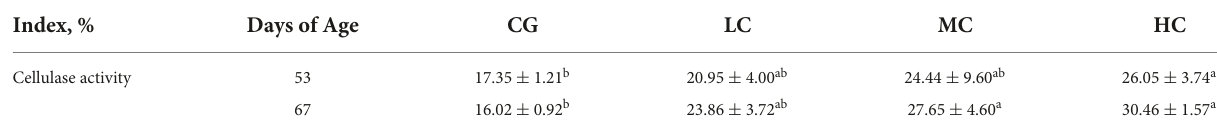
TABLE 3 The effect of C. butyricum on cellulase activity in Ira rabbit cecum. Index,